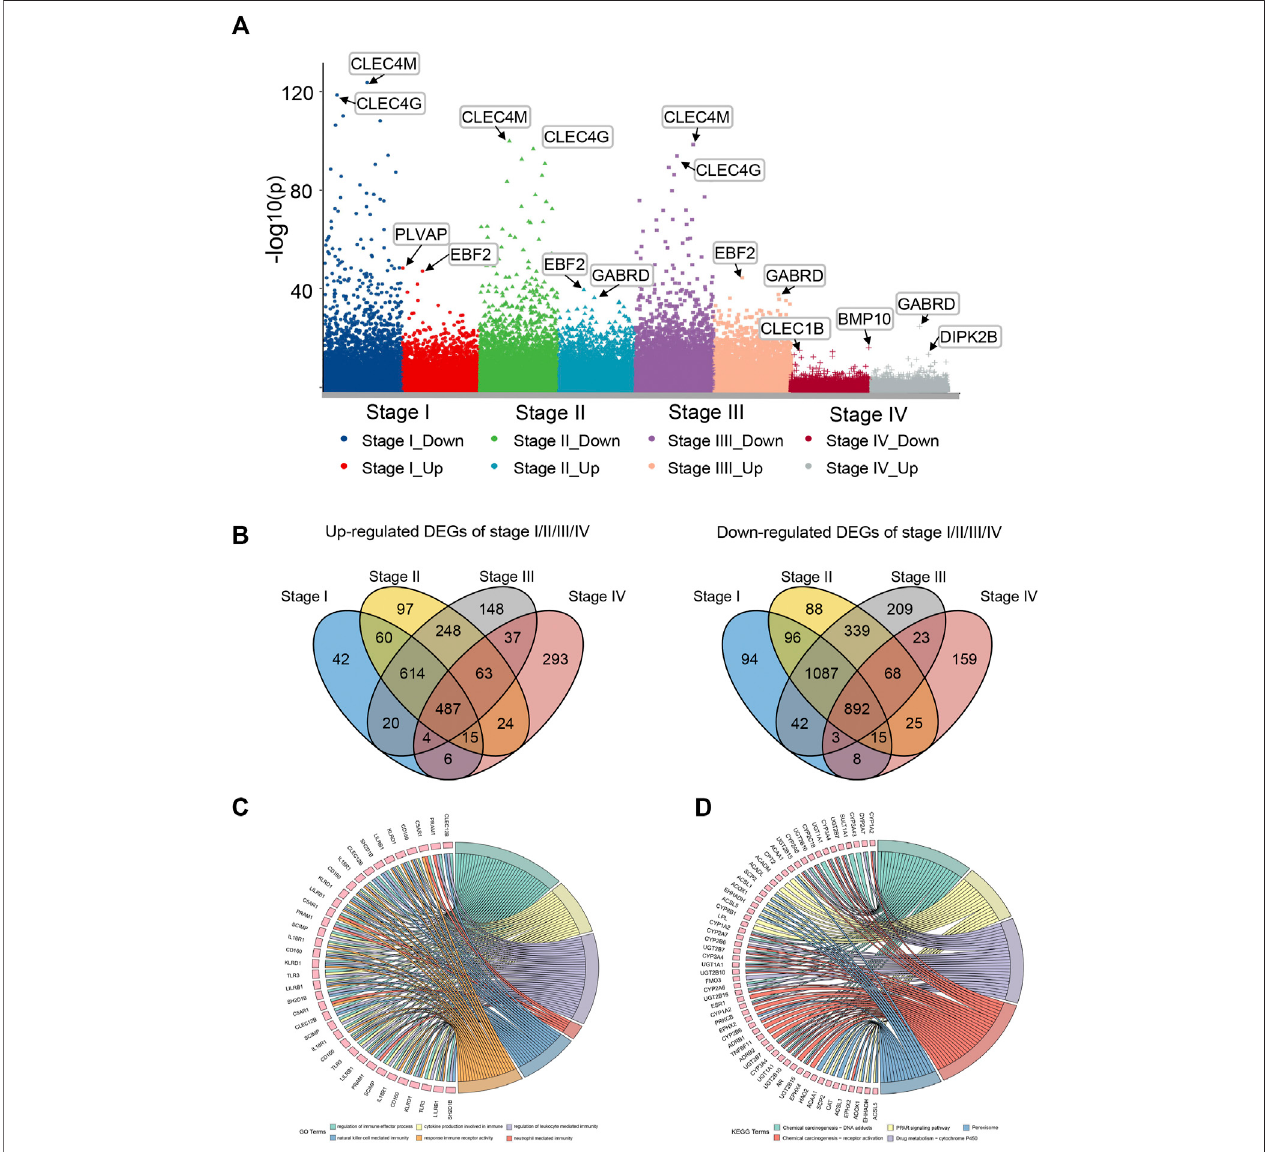
FIGURE 2 | Differential expression gene analysis and functional enrichment analysis. (A) Manhattan plot showed differentially expressed genes (DEGs) in different stages of LIHC. (B) Venn plot of up/downregulated common DEGs in LIHC stage I – IV. (C) GO enrichment analysis of LIHC-development genes. (D) KEGG pathway analysis of LIHC-development